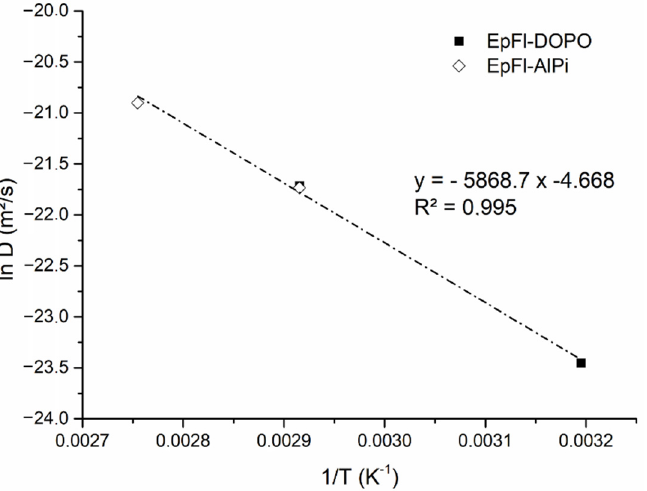
Figure 5. ln D versus 1/T curve for EpFl-AlPi and EpFl-DOPO for ageing at a w = 0.85.